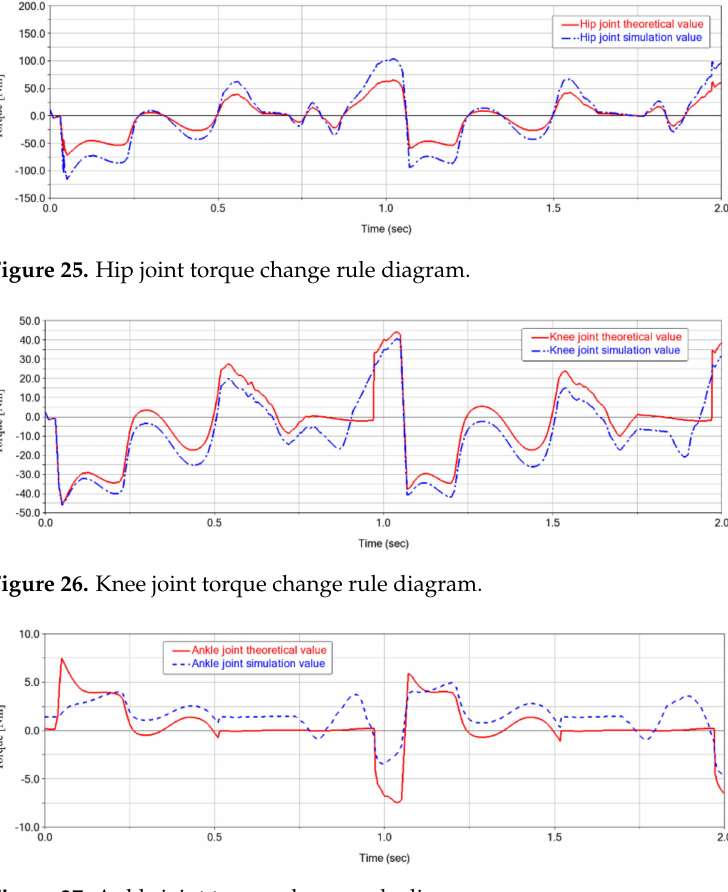
Figure 27. Ankle joint torque change rule diagram.